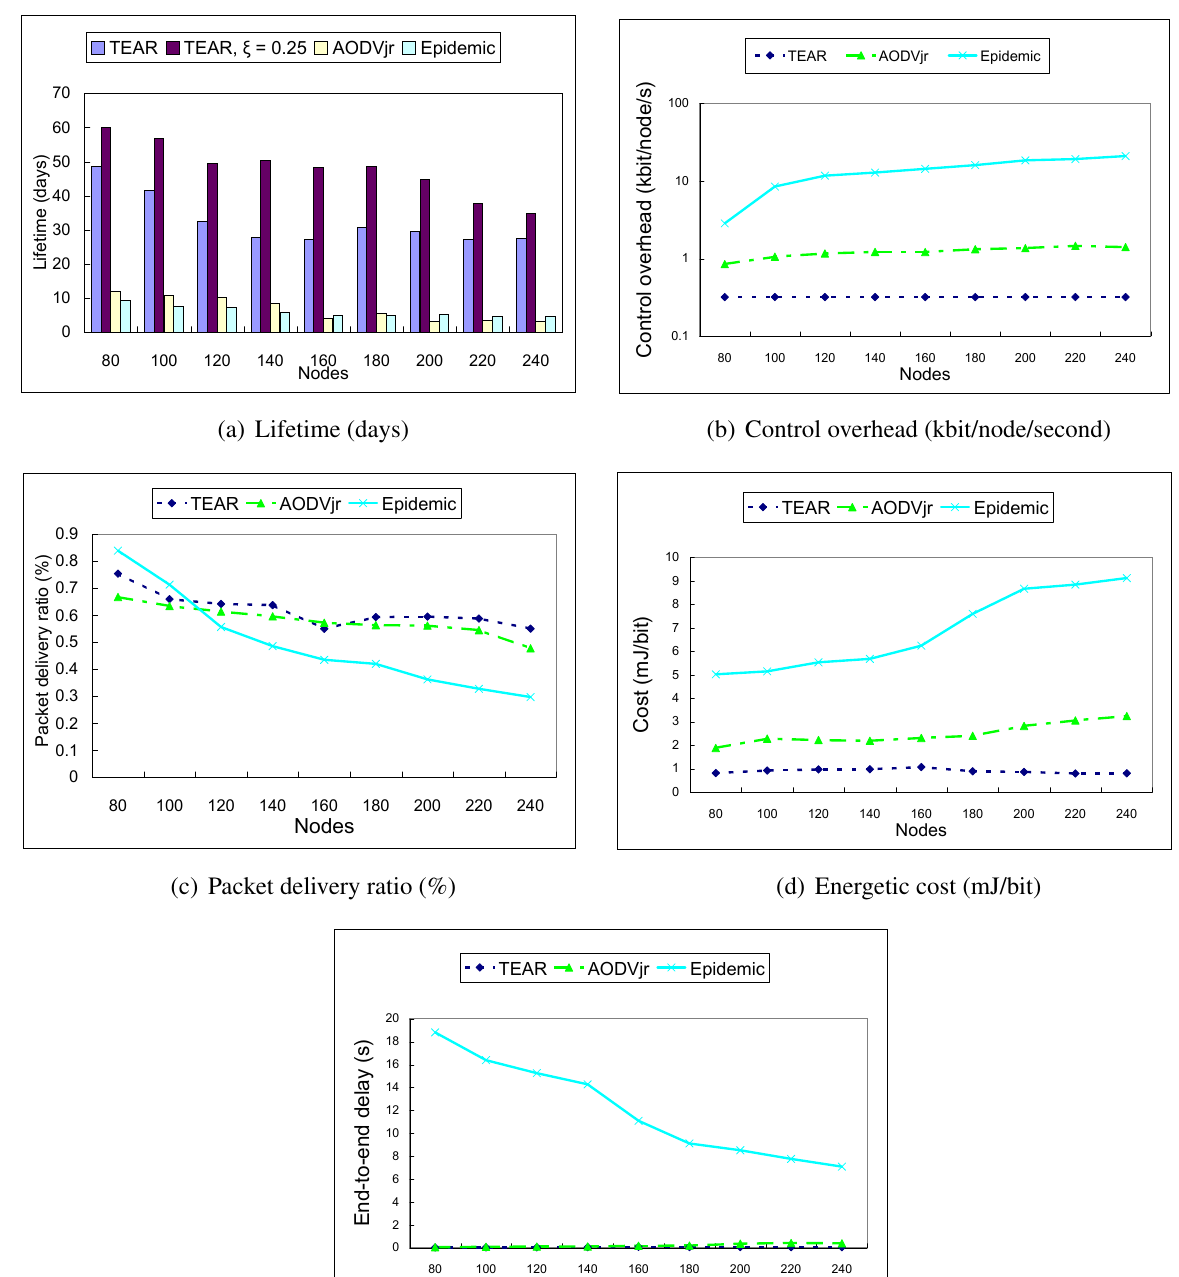
Figure 4. Protocol performance comparison vs. different density of